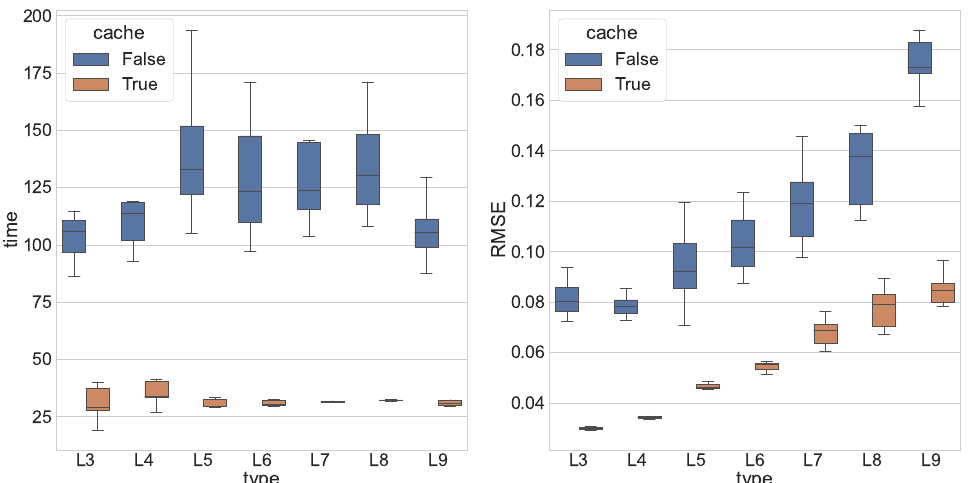
Figure 4. Legendre polynomial solution time in seconds ( left ) and solution error ( right ). The type is the order of polynomial n in Equation (12); different colors ( cache = false ) and ( cache = true ) cases are